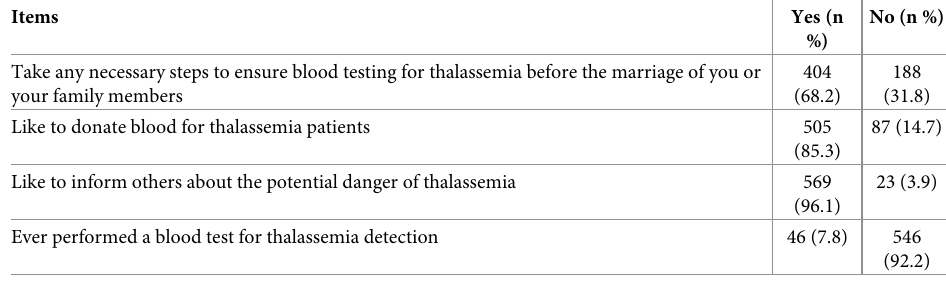
Table 5. Participant’s attitude and practice towards thalassemia (n =